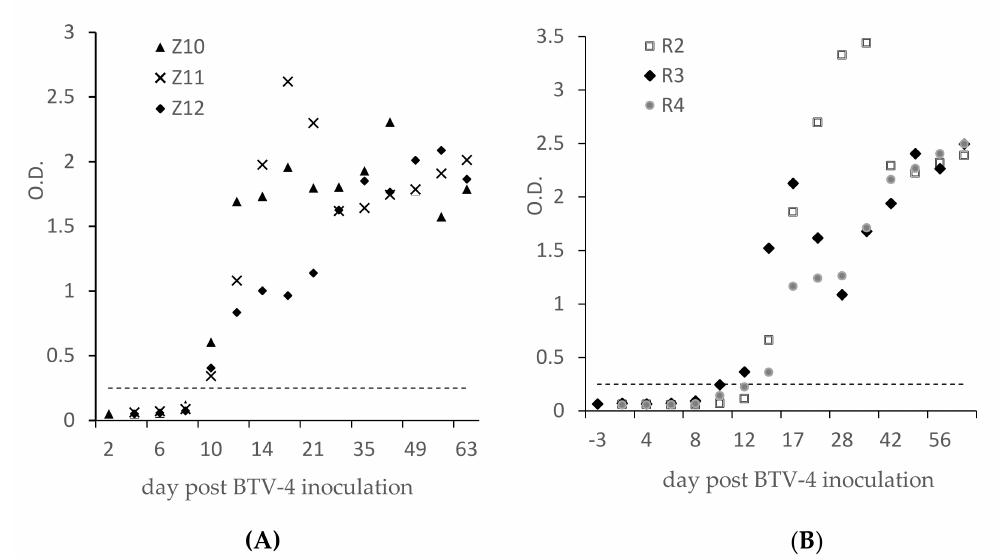
Figure 3. OD ELISA results from experimentally BTV-4 infected animals. Three goats (Z) ( A ) and three cattle (R) ( B ) were infected with the Bulgarian BTV-4 strain [19] at D0. The horizontal line represents the ELISA cut-off (OD = 0.25).